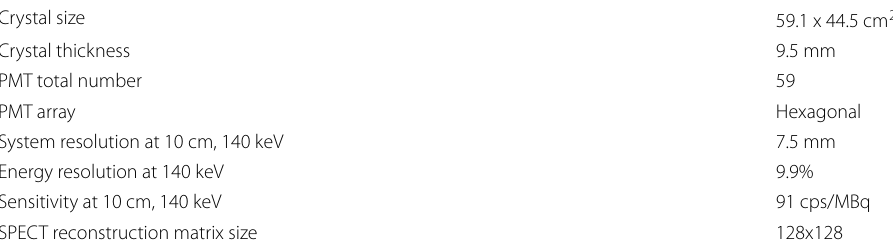
The system parameters were measured with 99 m Tc and LEHR